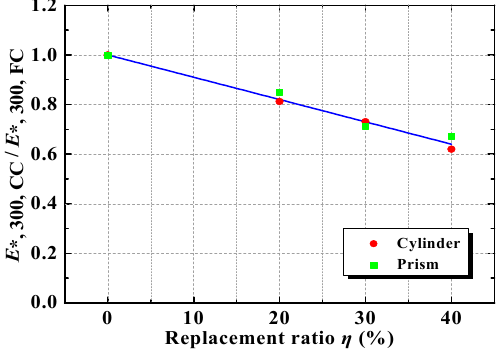
Figure 9. Variation of relative elastic modulus with replacement ratio of DCLs.